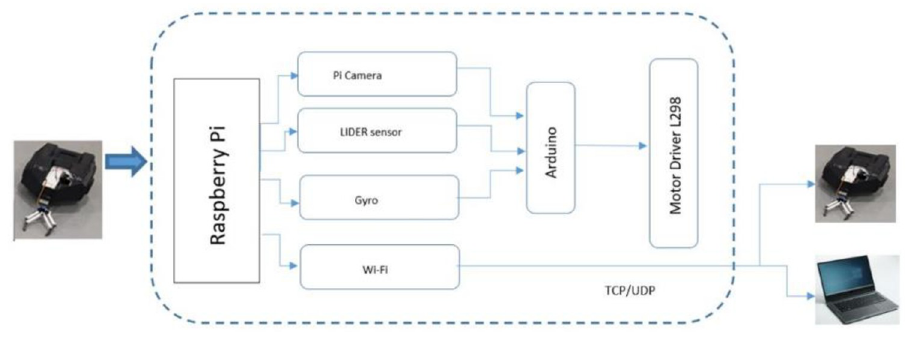
Fig 8. Internal hardware and resources of a robot.